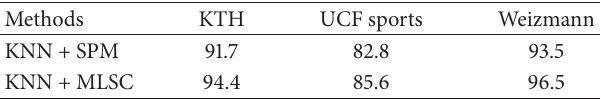
Table 2: Comparison results between MLSC with SPM (UNIT: %).